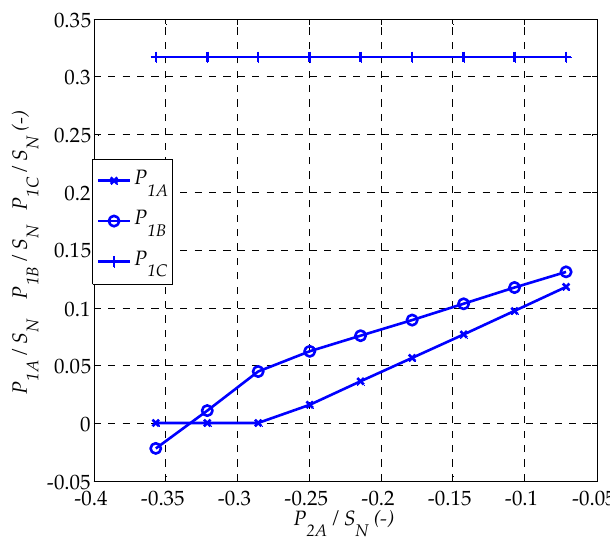
Figure 9. Active powers of the phases of the primary side of the transformer at the load R of phases B and C of the secondary side, as a function of the active power of the prosumer source in phase A of the secondary side, with amplitude–phase control.